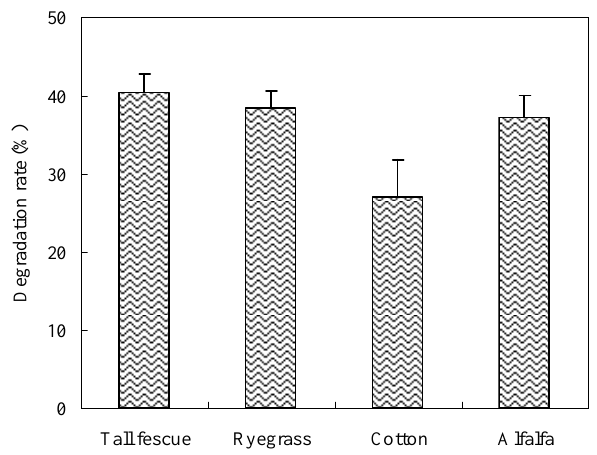
Fig. 1. Comparison of the abilities of different plant species to bioremediate TPH.